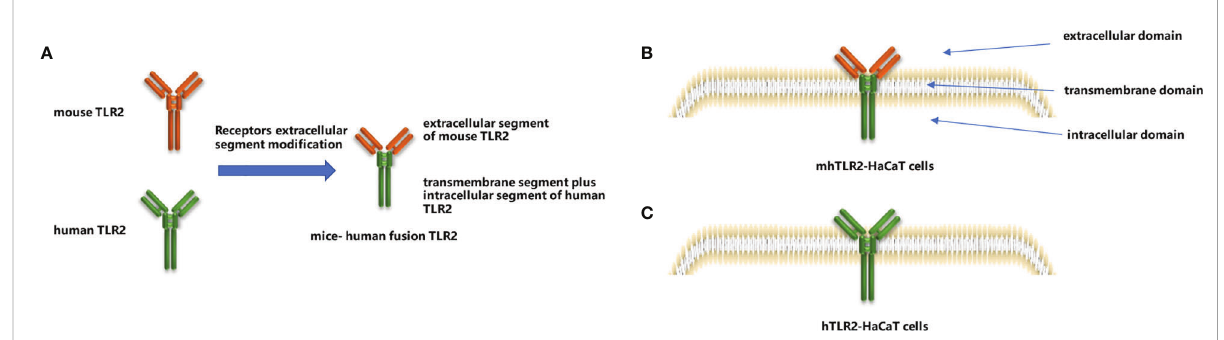
FIGURE 1 Construction of mice-human fusion TLR2 diagram (A) , diagram of mhTLR2-HaCaT cells (B) and hTLR2-HaCaT cells (C)